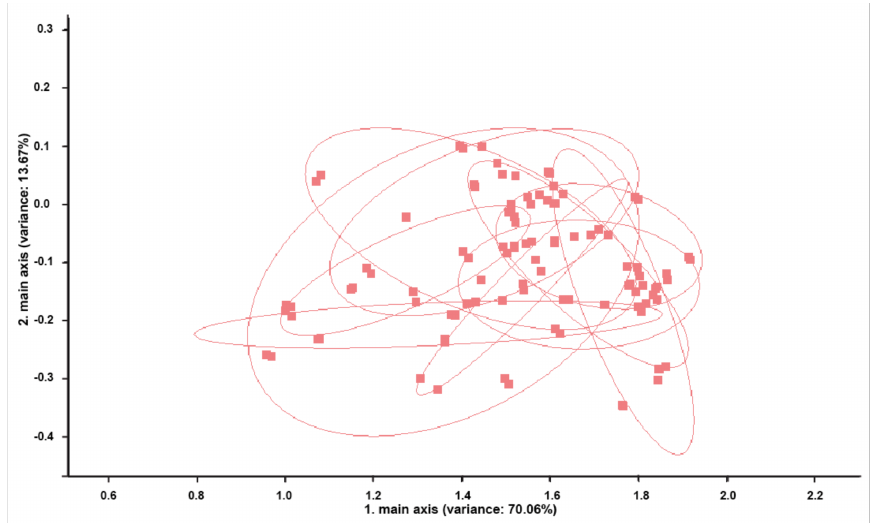
Figure 3. Principal components analysis (PCA) of perineal headspace sample measurements of